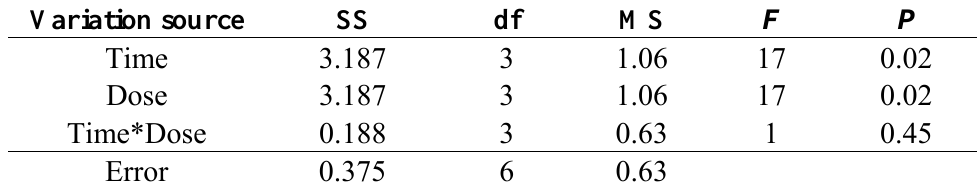
Table 1. Analysis of variance about neurological function defect.